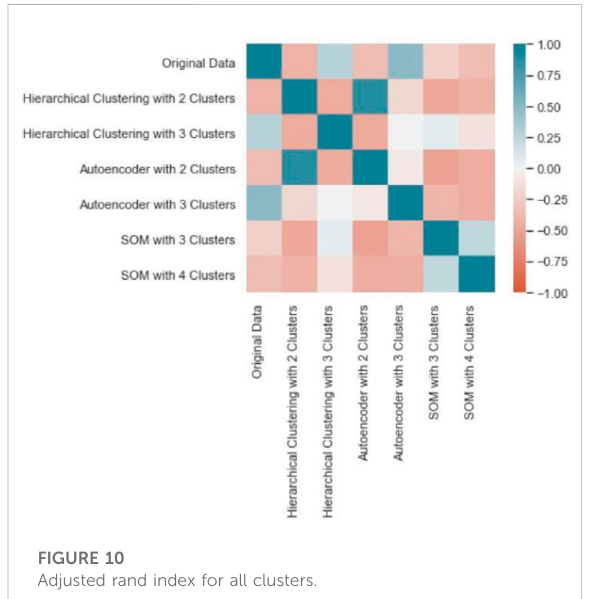
FIGURE 10 Adjusted rand index for all